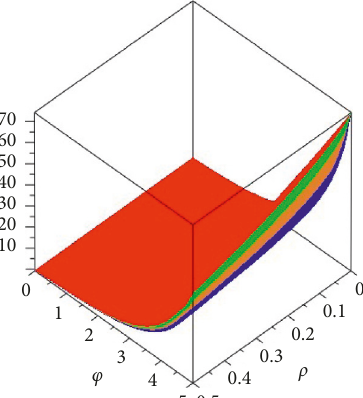
Figure 3: The graph shows different fractional orders of δ